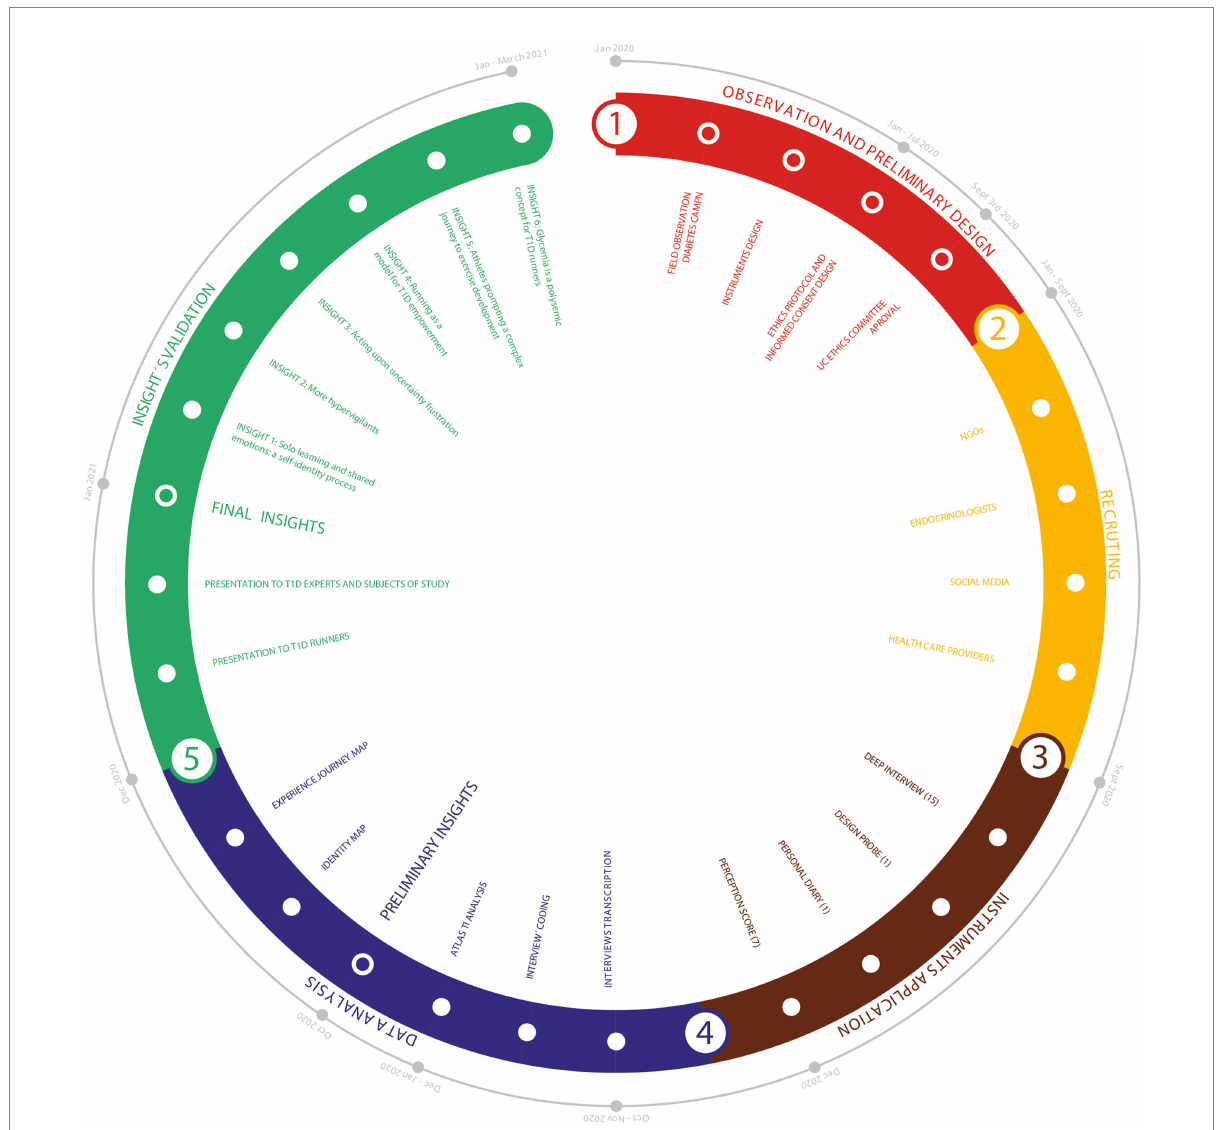
FIGURE 1 Illustration of the methodological design for recruitment, instruments, data analysis and